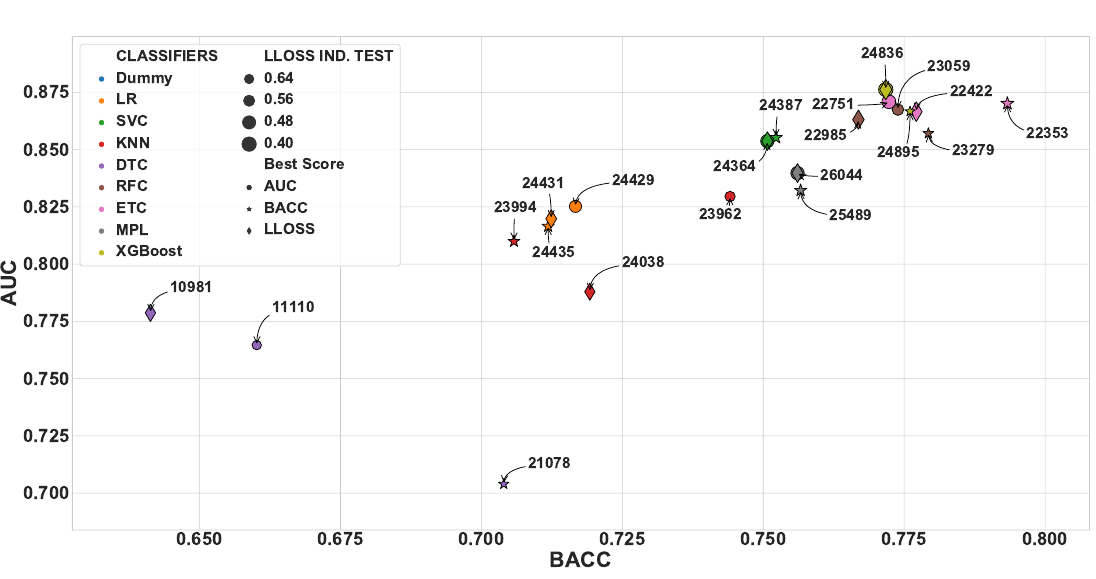
Figure 6. Independent test scores (BACC vs. AUC) for the best classifiers selected after the hyper-parameter optimization. The markers’ shapes represent the score used to select the best classifier, while the colors represent the classifier type. Similarly to the other figures, the marker size is inversely proportional to the LLOSS. The annotated numbers are the unique identifiers of each classifier. In this evaluation, only the all dataset was